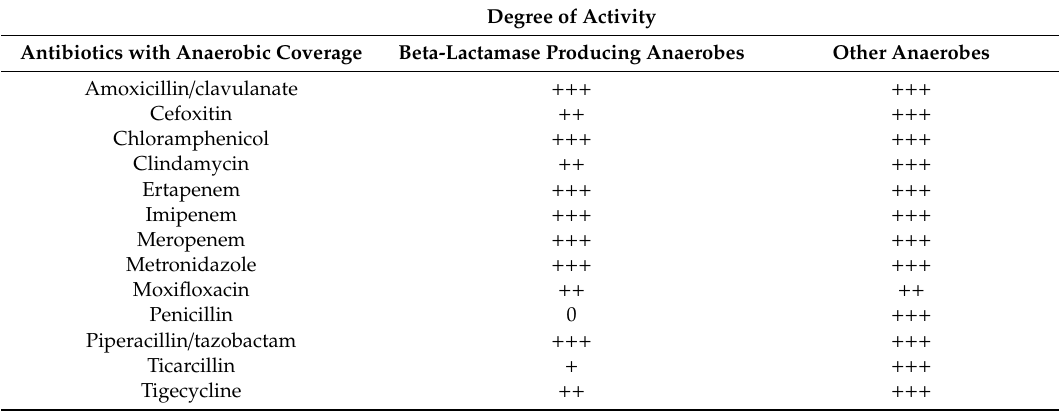
Table 1. Commonly used antibiotics with anaerobic